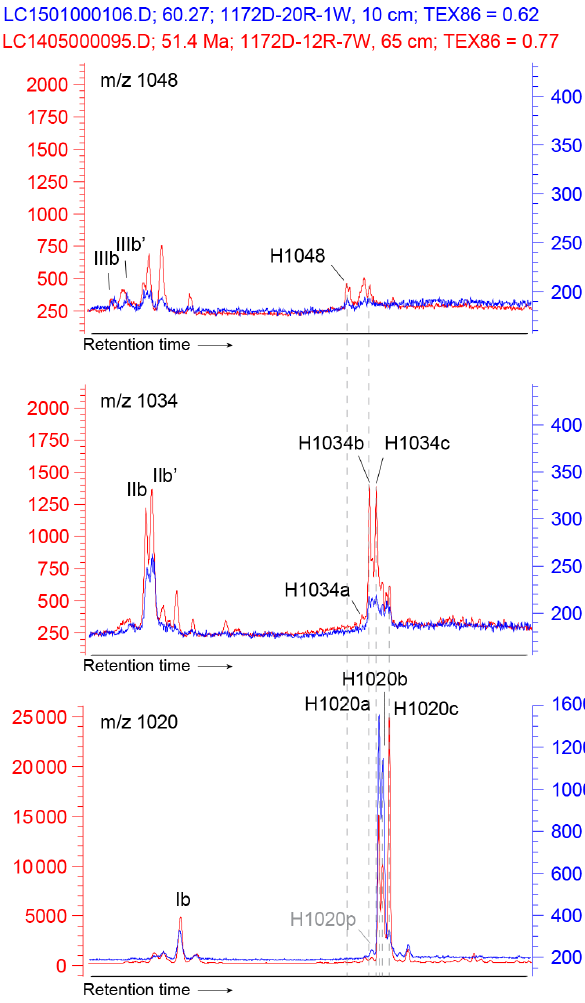
Figure 10. Stack of two UHPLC-MS chromatograms (1172D-12R- 7W, 65cm; 51.41Ma in red and 1172D-20R-1W, 10cm; 60.27Ma in blue) of m/z 1048, 1034 and 1020 traces, between ∼ 40 and ∼ 60min retention time, showing the pattern of peaks correspond- ing to brGDGTs and brGMGTs. Peak labels refer to the molecular structures in Fig. 3. Note that not all peaks are 3 times the baseline.